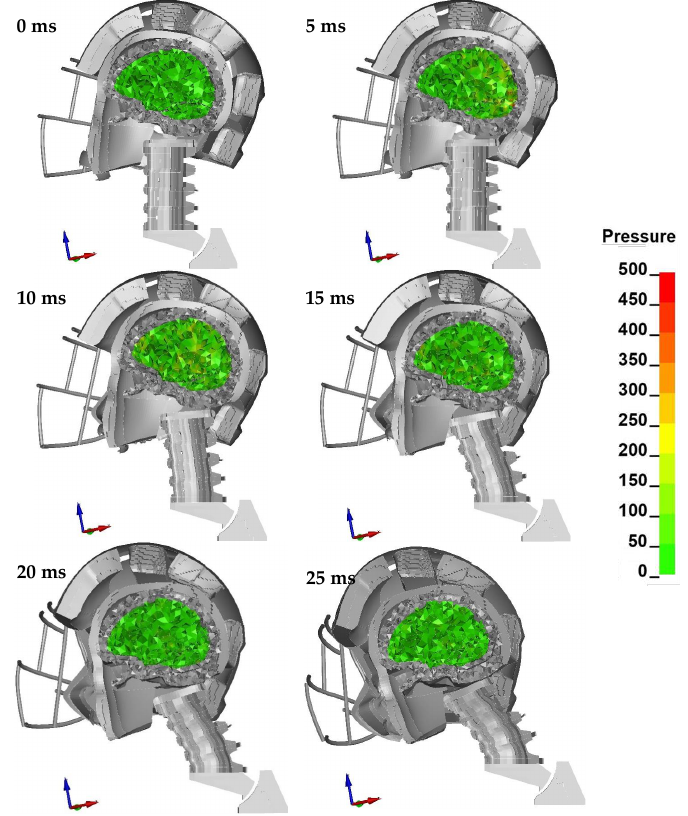
Figure A12. Head kinematics during the numerical test, configuration D, with the cross-section in the median plane and showing the hydrostatic pressure (kPa) in the cerebrum.